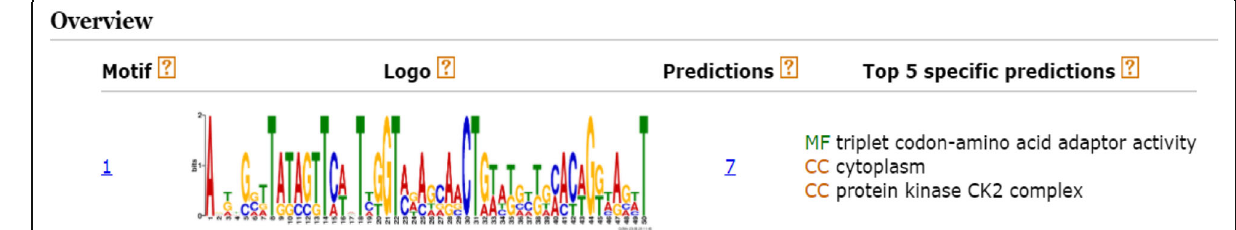
Fig. 3 Logo sequence for investigated common Mtrn I